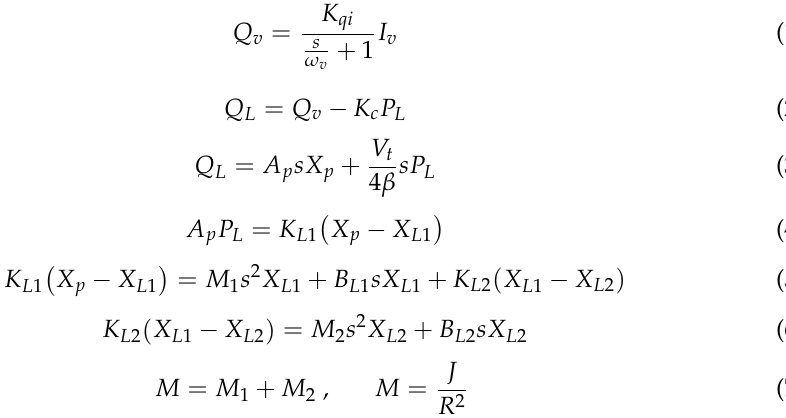
Figure 3. The physical model of the hydraulic actuator and the driven kerolox engine. The mathematical equations are presented in Laplace-form Equations (1)–(7).